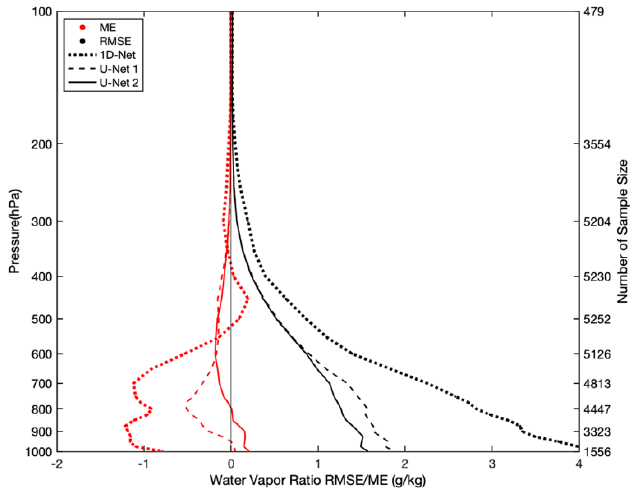
Figure 15. Same as Figure 14 except for all sky.